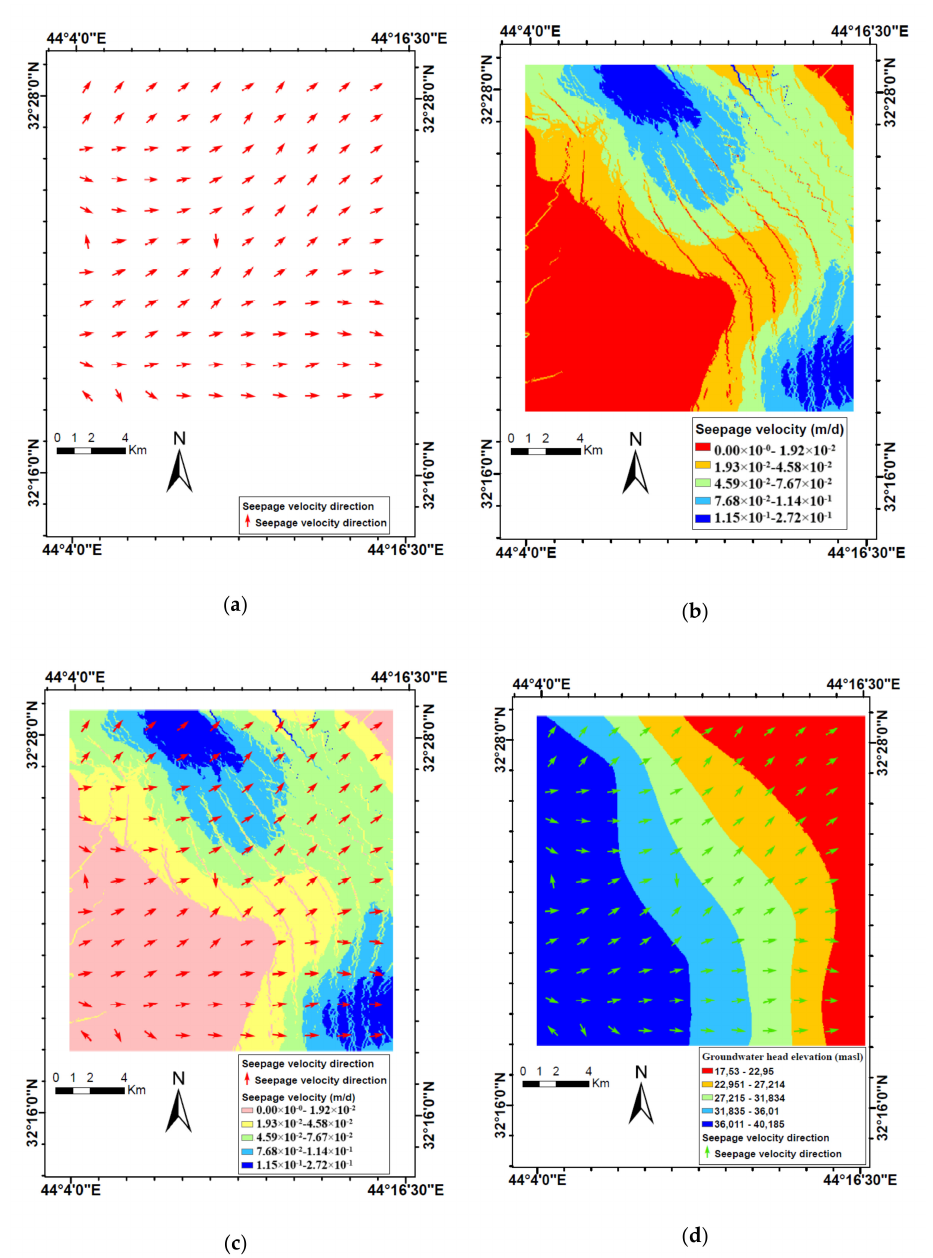
Figure 17. Seepage velocity map for Dibdibba groundwater: ( a ) direction map; ( b ) magnitude map; ( c ) merged magnitude–direction map; ( d ) seepage direction–groundwater elevation head